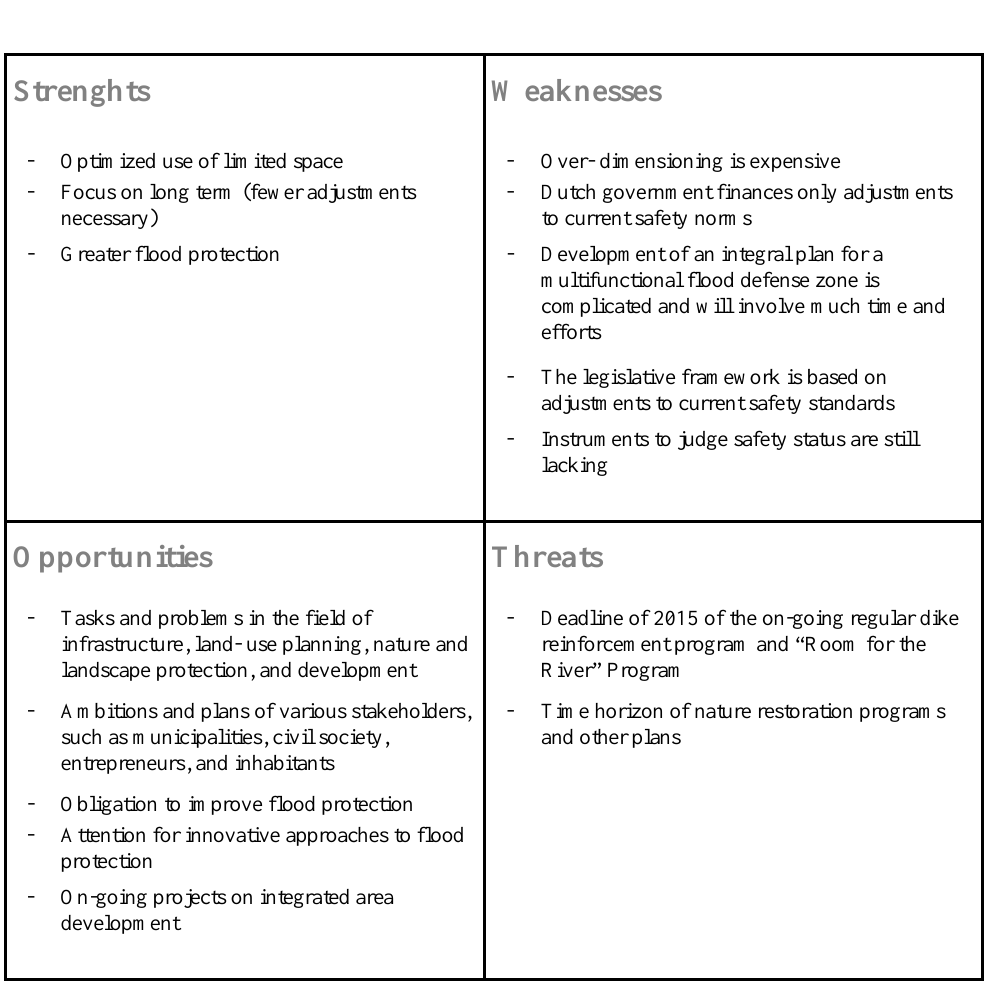
Fig. 5. SWOT analysis based on the